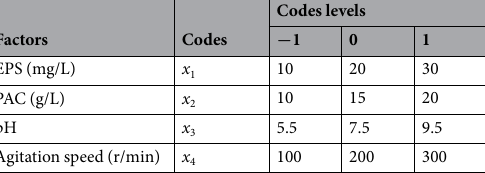
Table 4. Coded levels for four variables framed by the Central Composite